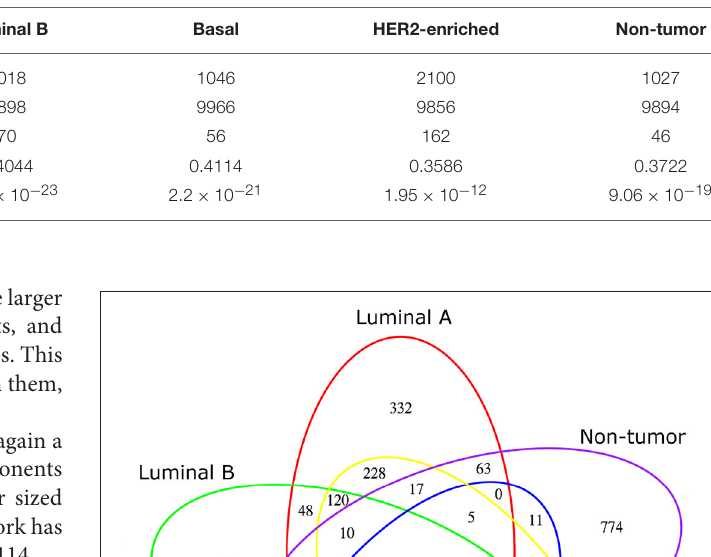
TABLE 1 | Network metrics.